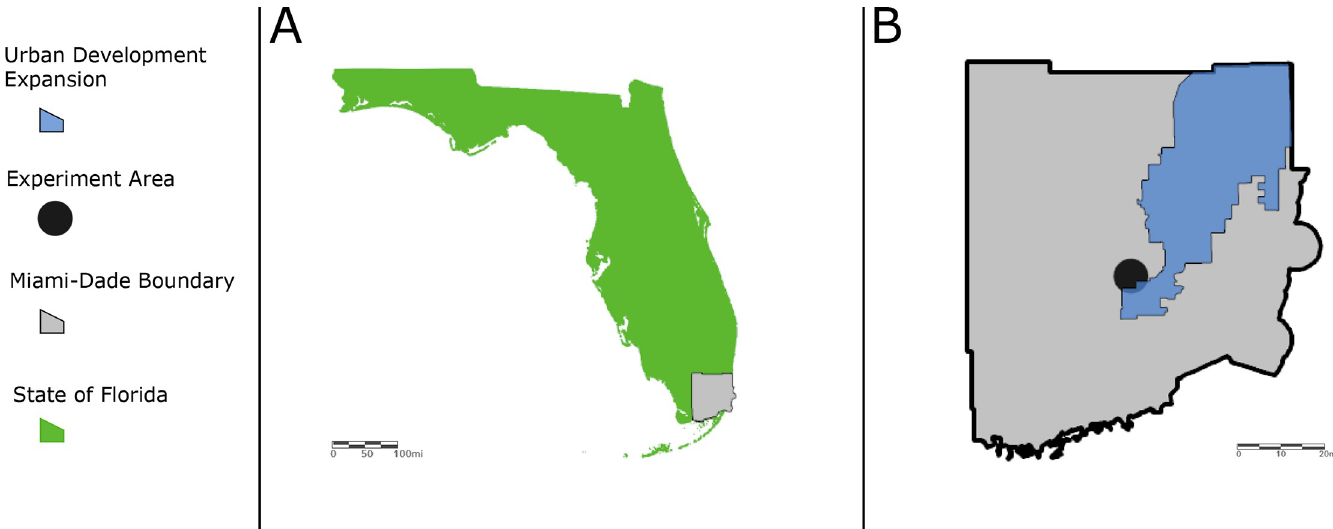
Fig 1. Maps displaying the approximate location of the tire shop in Miami-Dade County, Florida. (A) State of Florida; (B) Miami-Dade County. Coordinates: 25.775589, -80.196845.